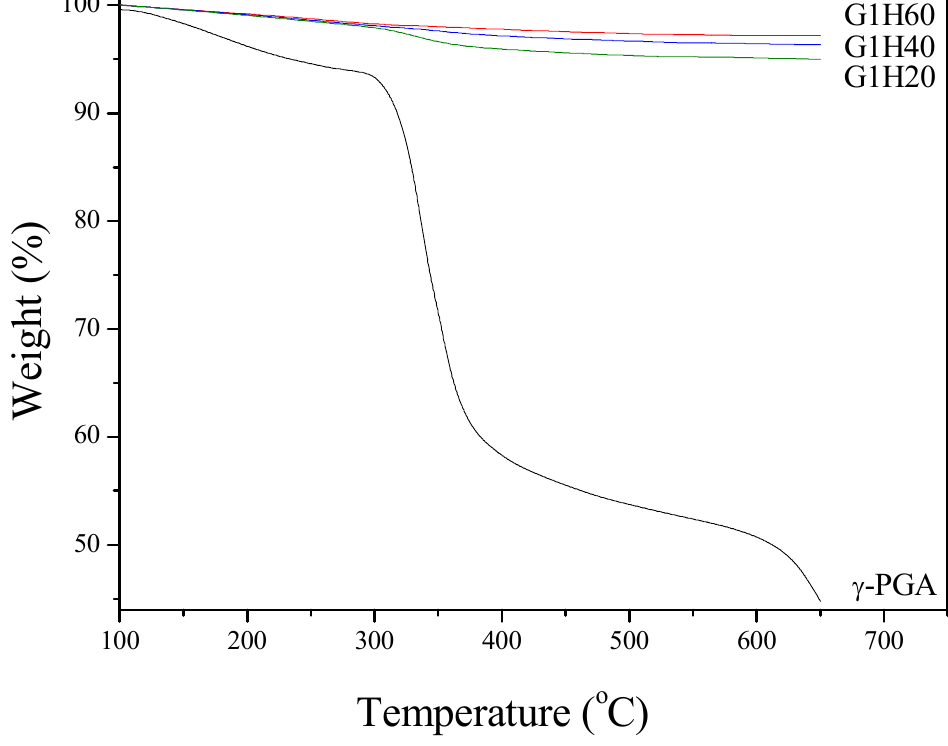
Figure 2. Thermal gravimetric analysis (TGA) curves of γ-PGA and PGA-AP nanoparticles.